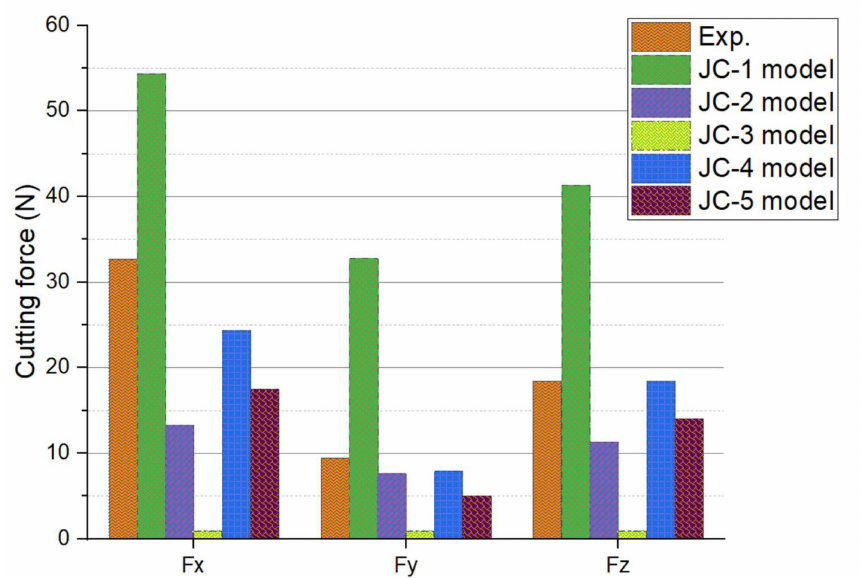
Figure 4. Comparison of predicted and experimental results of cutting force with different models.